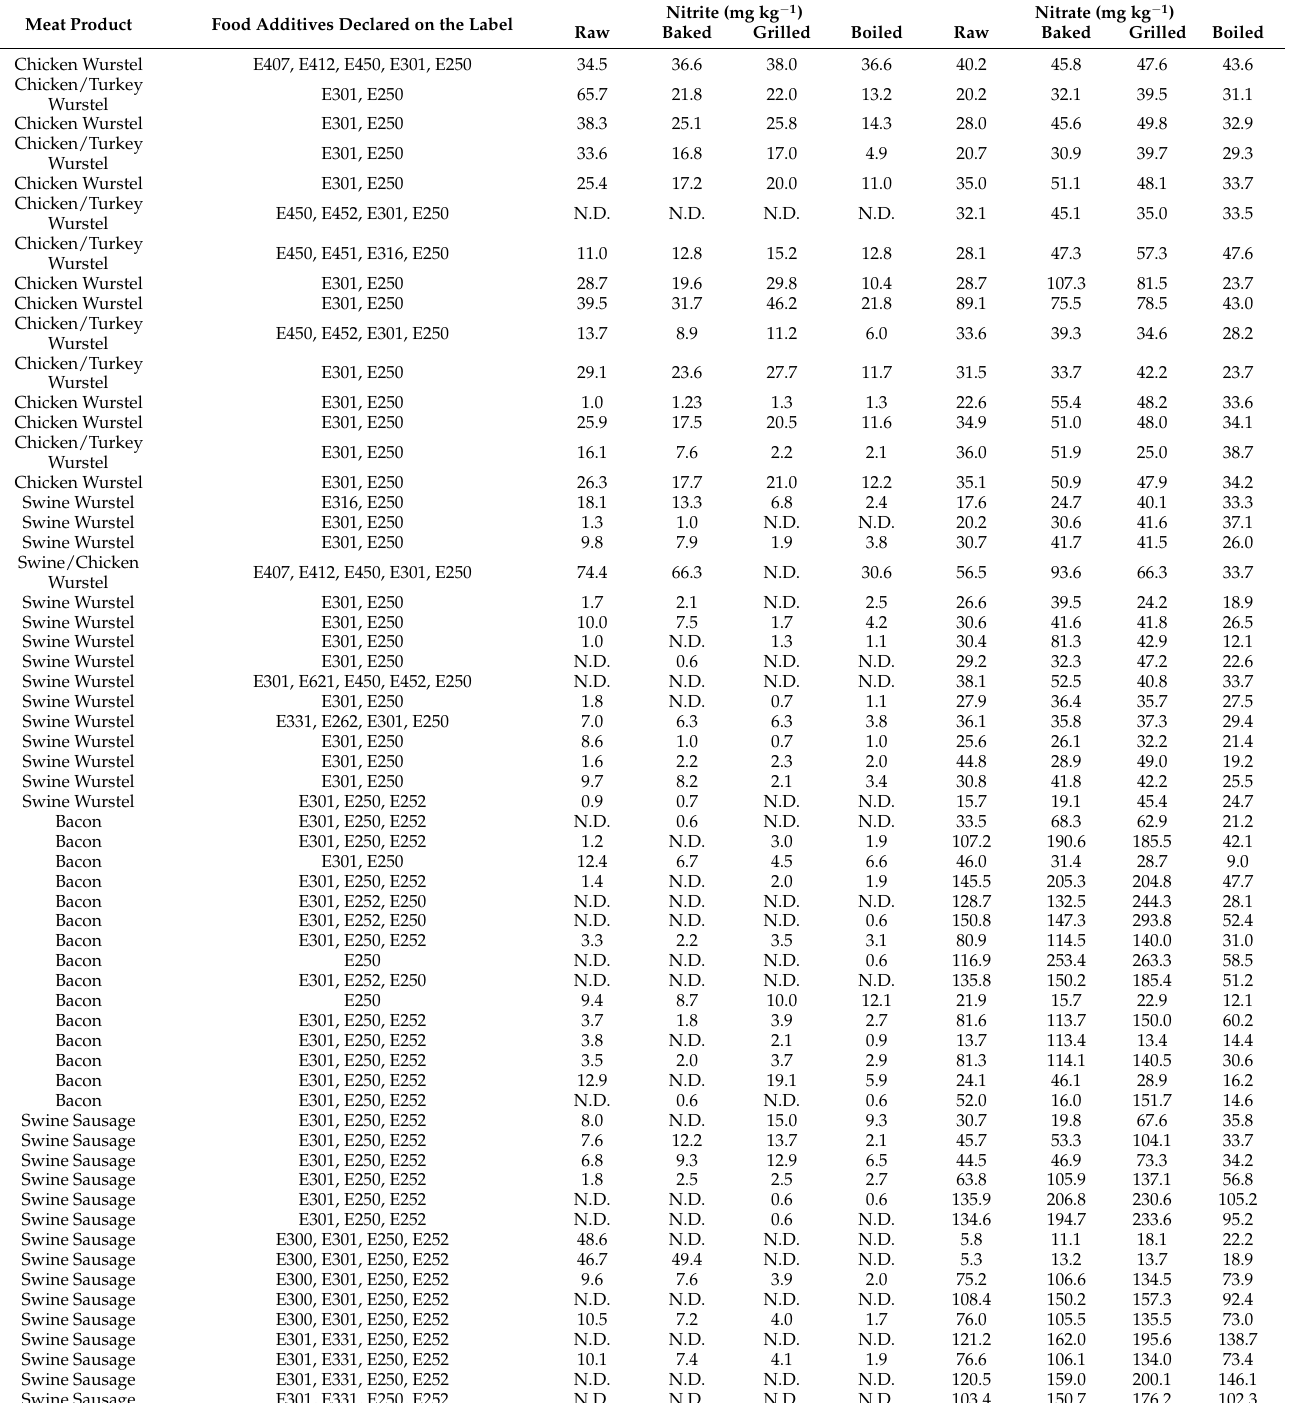
Table 1. NaNO 2 and NaNO 3 concentrations detected in 60 samples of meat products analyzed before and after